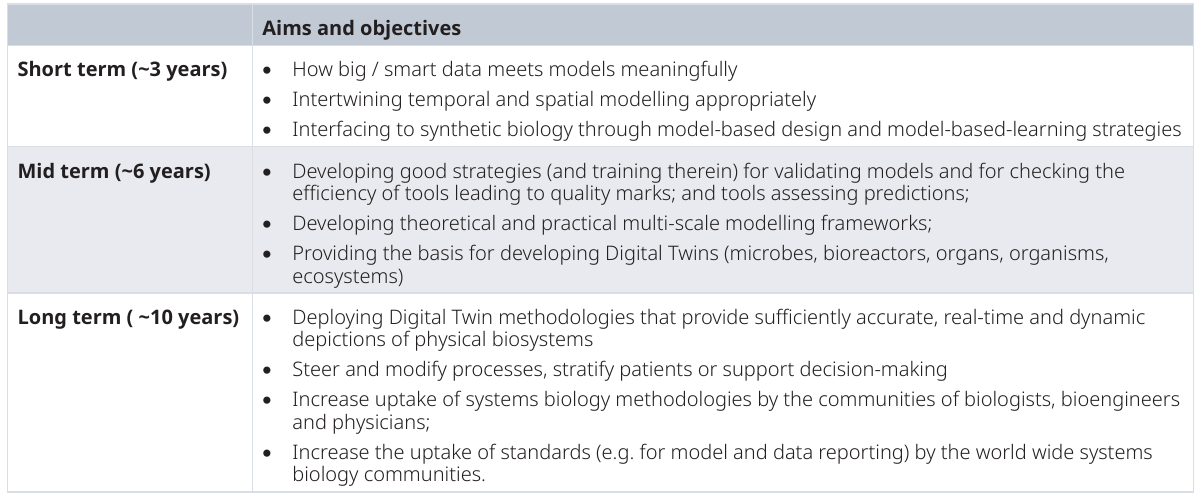
Table 5. Breakdown of short, mid and long term objectives for the Technology